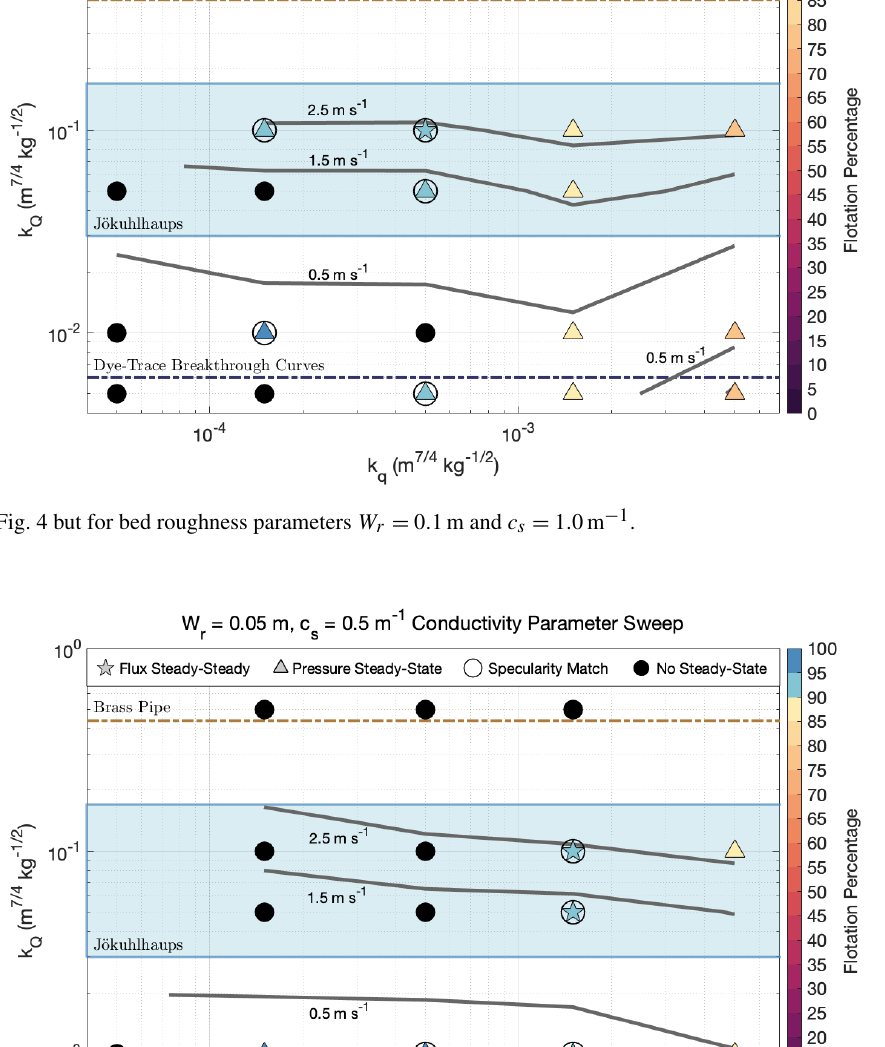
https://doi.org/10.5194/tc-16-3575-2022 The Cryosphere, 16, 3575–3599,